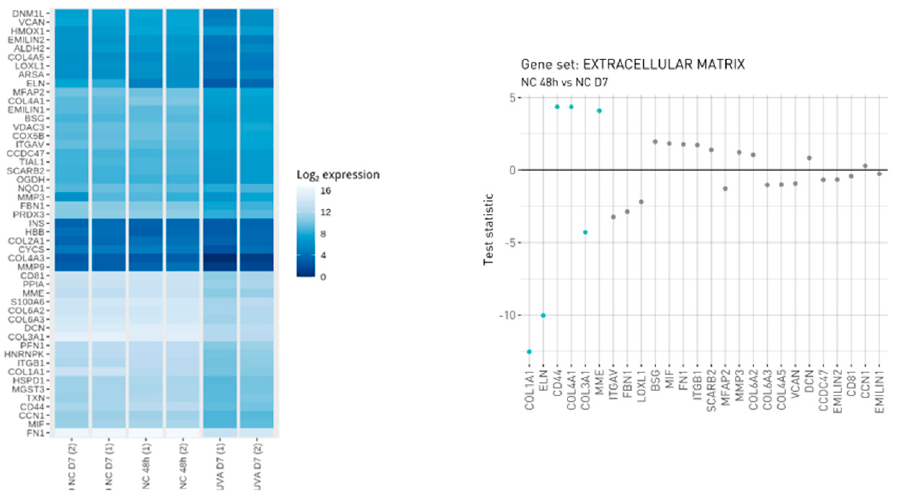
Figure 1. Visualization of observed expression levels. The left figure is a heatmap that displays the log2-transformed expression values and the right figure displays gene level statistics for genes within the manually curated gene sets. Statistics correspond to those from the differential expression analysis comparing NC_48 h vs. NC_D7 (analysis performed in triplicate, each replicate is a pool of 20 spheroids on 150 – 200 µm in size diameter).